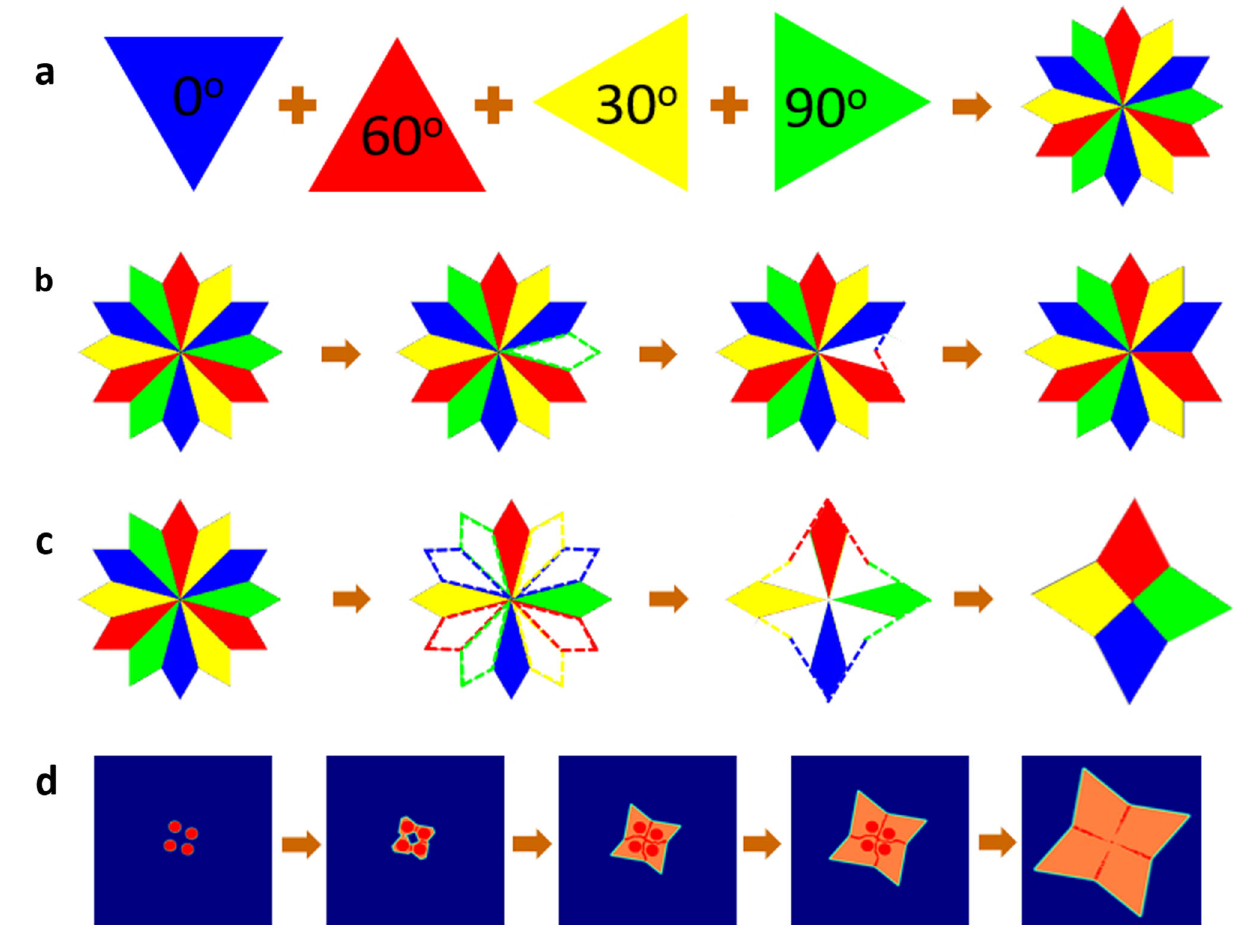
Fig. 5 Formation of steady-state polycrystals formed from the coalescence of triangular grains on a fourfold symmetric substrate. a Schematics on the construction of the steady-state polycrystal with the largest number (12) of convex vertices formed from the coalescence of triangular grains with four different orientations on an fcc(100) surface. b , c Schematics on the construction of the steady-state polycrystals with 11 and 4 convex vertices based on the polycrystal with 12 convex vertices, respectively. Convex vertices that are chosen to disappear are denoted by dashed outlines. d PFT simulation showing an example of the formation of a polycrystal by coalescence of four single-crystalline islands with different orientations. The fi fth panel is zoomed out for a better view.